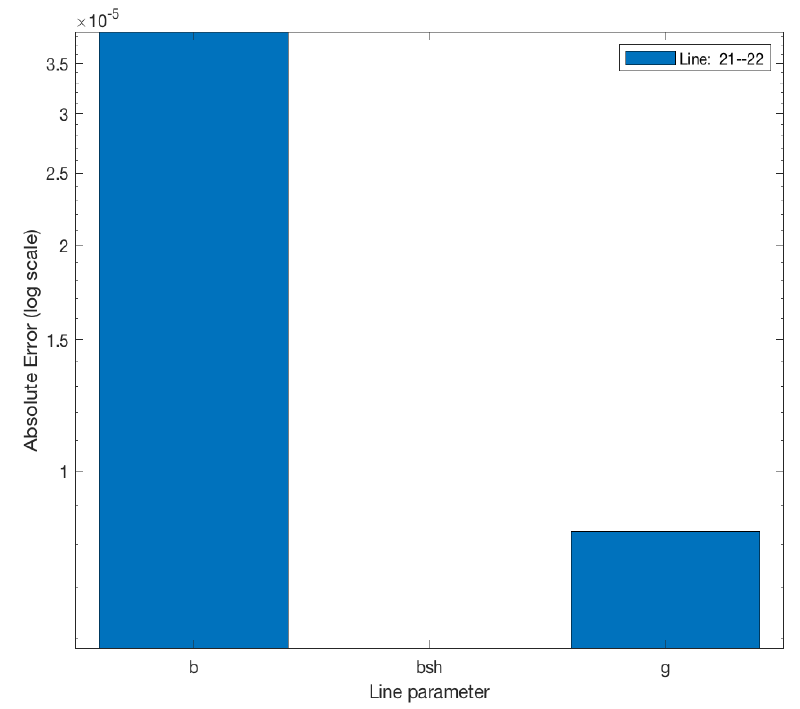
Figure 5. Absolute error of line parameter correction single line